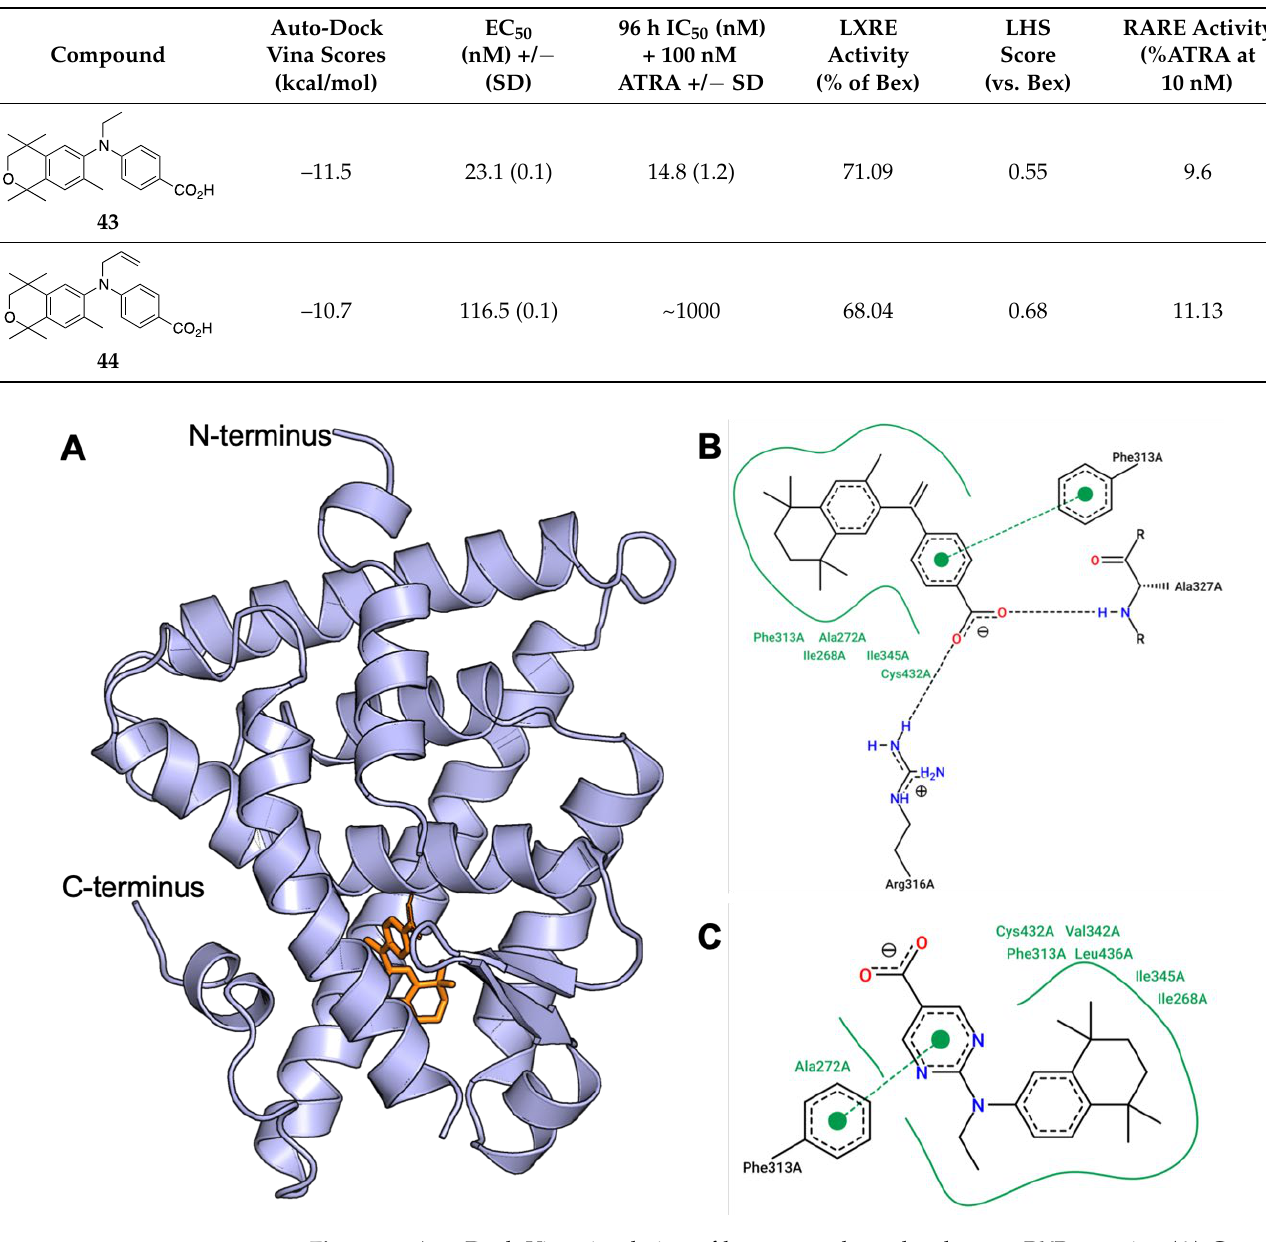
Figure 3. AutoDock Vina simulation of bexarotene bound to human RXR protein. ( A ) Cartoon representation of the human RXR alpha ligand binding domain (PDB:1FBY, blue) and the docked compound bexarotene (orange). N- and C-termini are labeled. ( B , C ) Two-dimensional depiction of the interactions between protein residue sidechains with bexarotene ( B ) and compound 26 ( C ) using PoseView (BioSolvIT [73,74]). In both ( B ) and ( C ), hydrogen bonds are presented as dashed lines between interaction partners, and hydrophobic interactions are depicted as smooth contour lines.